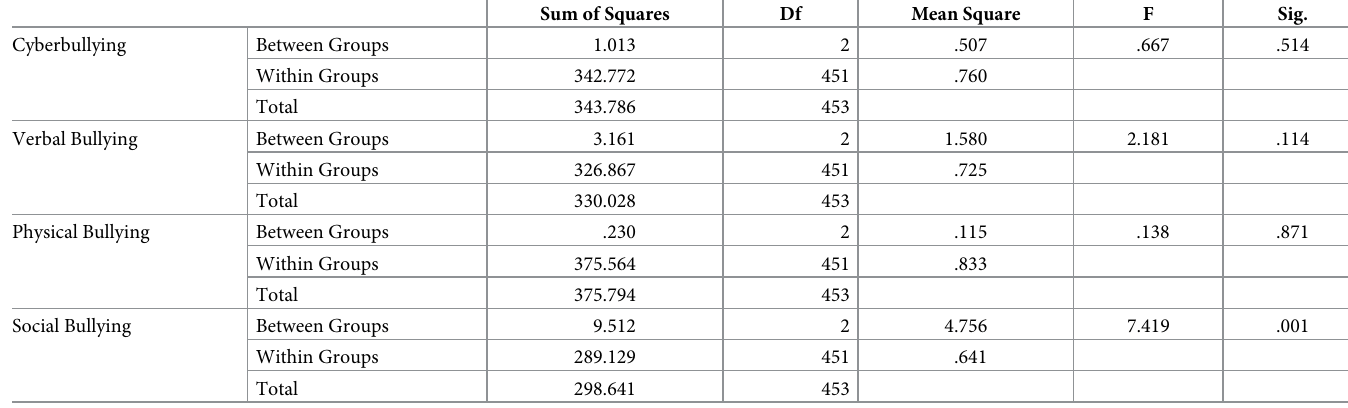
Table 7. ANOVA. Dependent Variable: Form of Bullying.